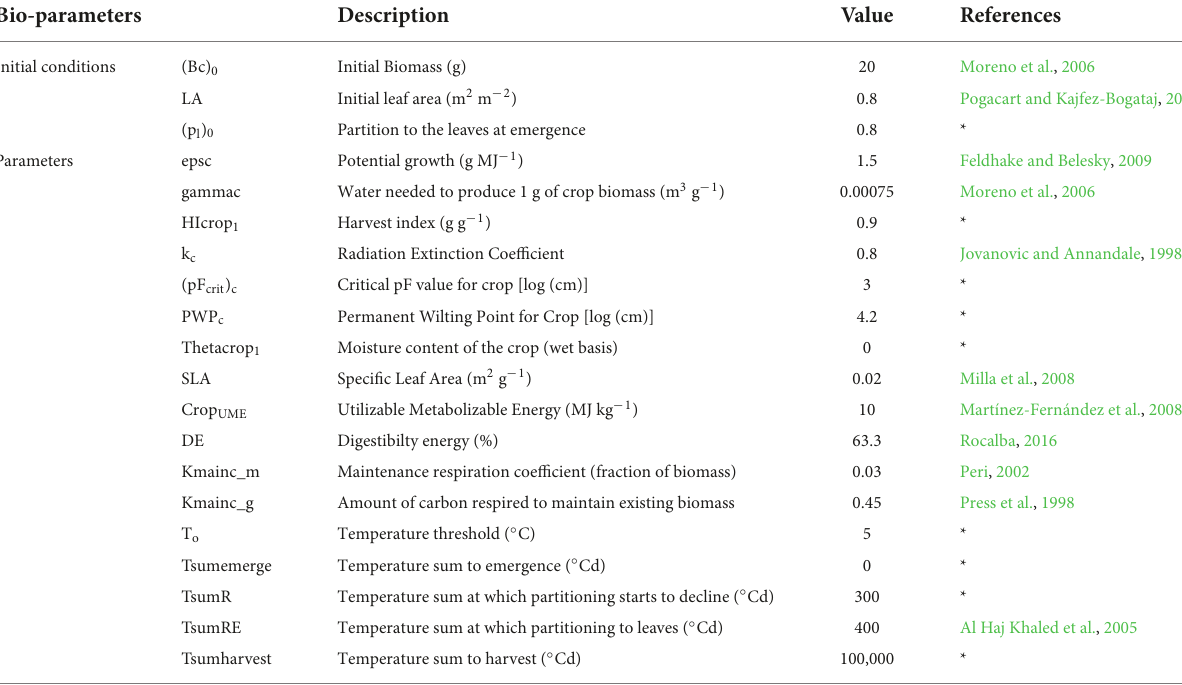
TABLE 2 Pasture parameters ( Dactylis Glomerata ) used in the calibration and validation of the Yield-SAFE model.